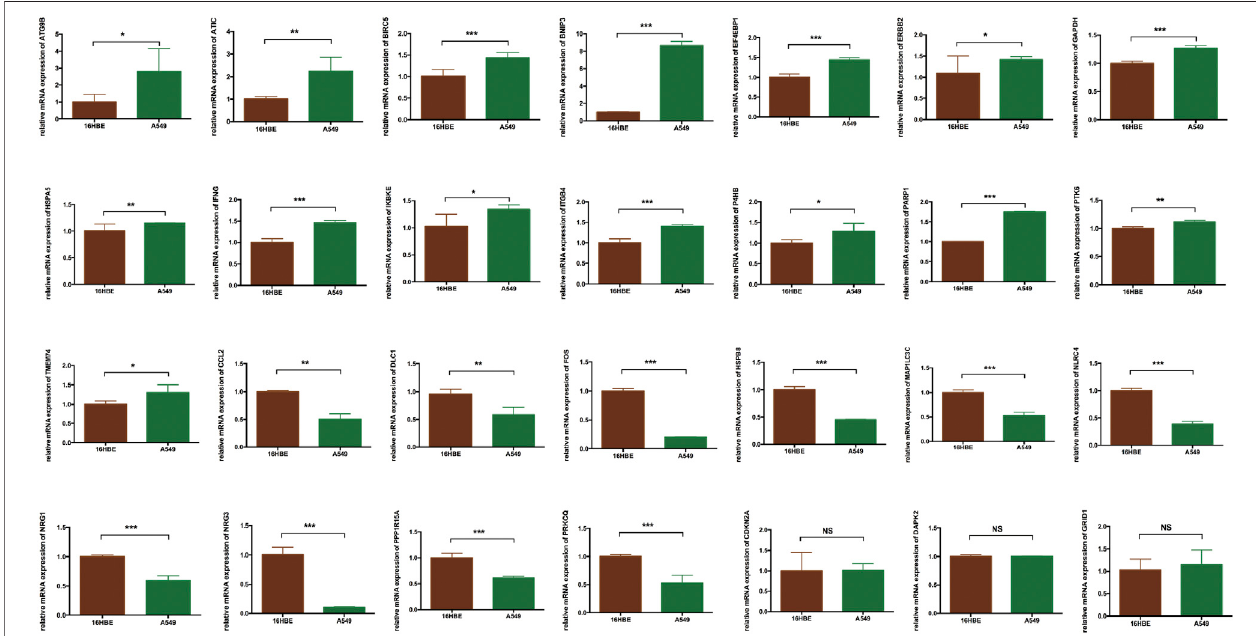
FIGURE7| Thevalidationof28DEARGsinLUADusingqRT-PCR,inwhich25ofthe28genesshowedthesigni fi cancein16HBEcomparedwithA549celllines(all p < 0.050), while three genes showed that there is no signi fi cance between 16HBE and A549 cell lines (all p > 0.050). DEARGs, differentially expressed autophagy- related genes; LUAD, lung adenocarcinoma; qRT-PCR, quantitative reverse transcription – polymerase chain reaction.